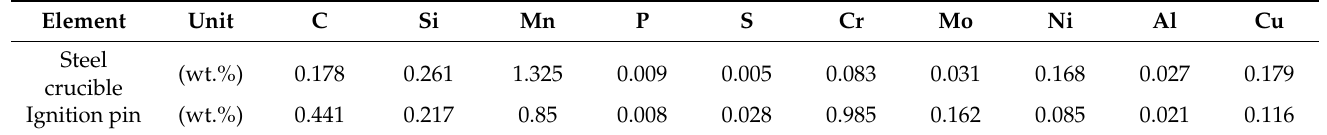
Table 5. Chemical composition of ignition pin and steel crucible.